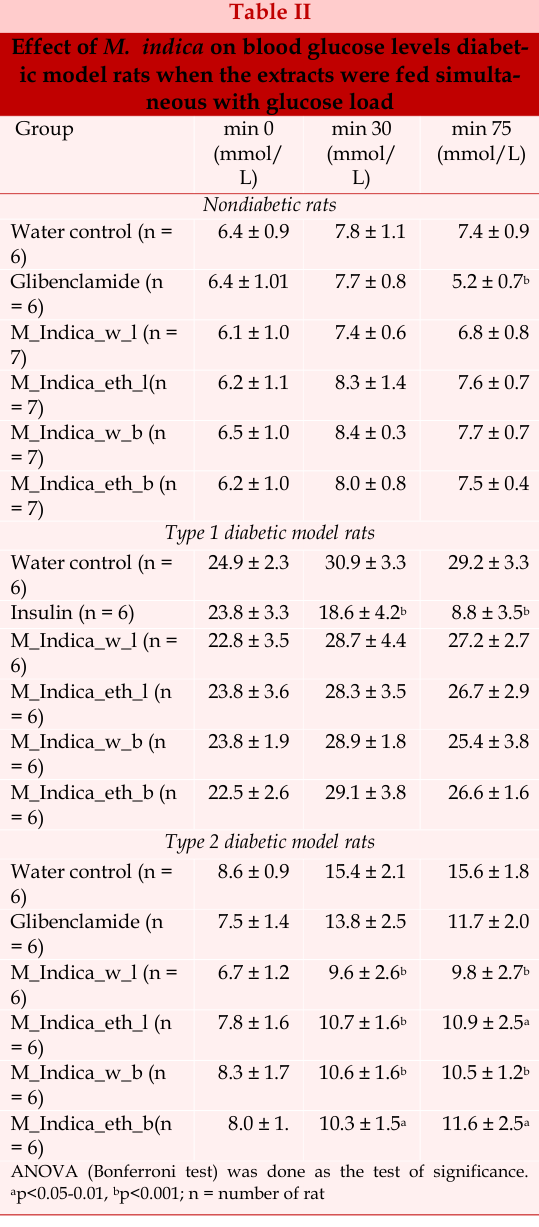
Effect of M. indica of fasting blood glucose levels of diabetic model rats